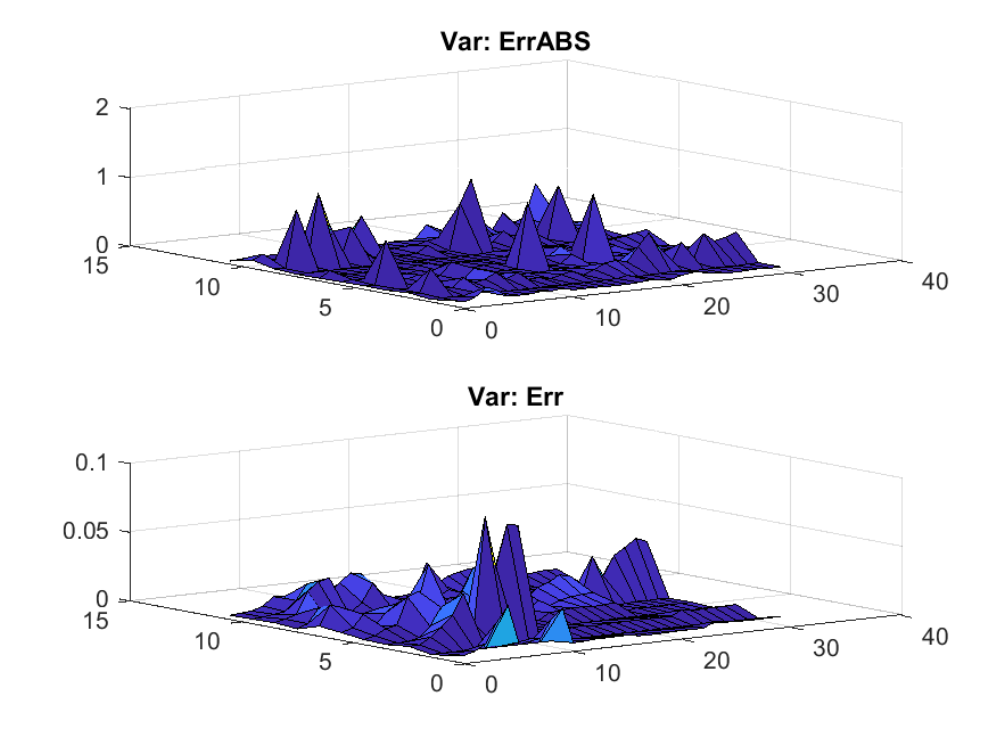
Figure 14. Absolute error (ErrABS) and relative integral errors (Err) for all 31 markers and all 11 segments of CMU 86 Trial 1 using two centers and 49